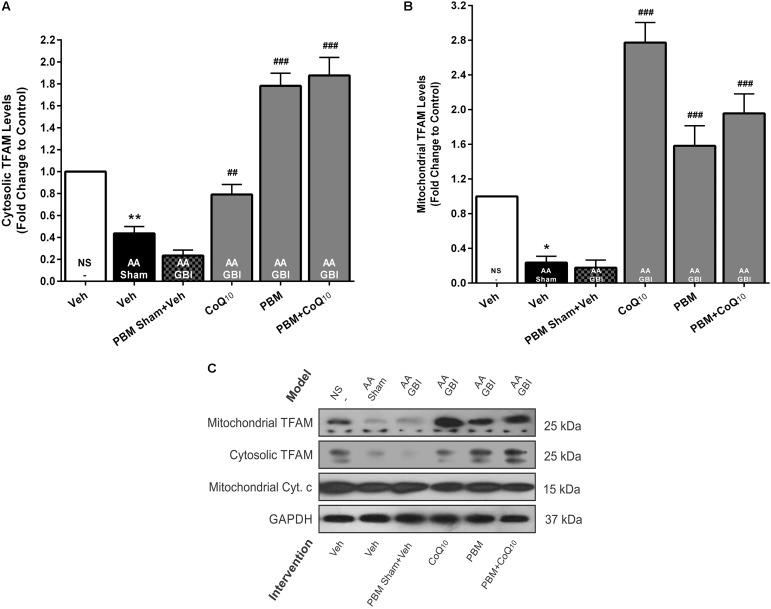
(A) Cytosolic and (B) mitochondrial TFAM levels in brain tissue of different groups. Each bar represents the mean ± SEM, (n = 6). ∗p < 0.05 and ∗∗p < 0.01 compared with the NS (control). ##p < 0.01 and ###p < 0.001 compared with AA + GBI. (C) Representative images of cytosolic and mitochondrial TFAM protein levels detected by western blot. The GAPDH and Cyt. c were used as cytosolic and mitochondrial internal controls, respectively. AA, artificially aged; CoQ10, Coenzyme Q10; Cyt. c, cytochrome c; GBI, global brain ischemia; NS, normal saline; PBM, photobiomodulation; TFAM, mitochondrial transcription factor; Veh, Vehicle.